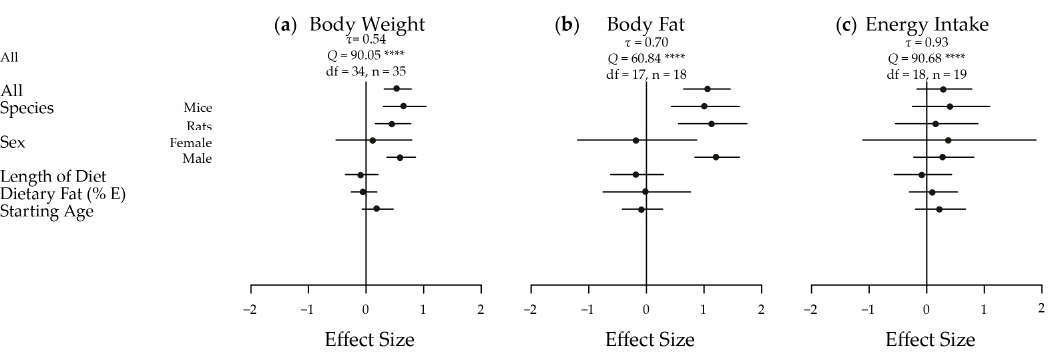
Figure 2. Meta-analysis of the extracted results for body weight, body fat and energy intake in high versus low glycaemic index fed animals. A plot of the calculated effect size and sampling variance for each of the three traits either as a whole or broken down by confounding factor: ( a ) Body Weight; All, Length of Diet and Dietary Fat n = 35, Mice n = 14, Rats n = 21, Female n = 4, Male n = 31, Starting Age n = 32; ( b ) Body Fat; All, Length of Diet and Dietary Fat n = 18, Mice n = 9, Rats n = 9, Female n = 2, Male n = 16, Starting Age n = 17; and ( c ) Energy Intake; All, Length of Diet and Dietary Fat n = 19, Mice n = 10, Rats n = 9, Female n = 2, Male n = 17, Starting Age n = 18. n , number of effect sizes; df , degrees of freedom; E, energy. **** p < 0.0001